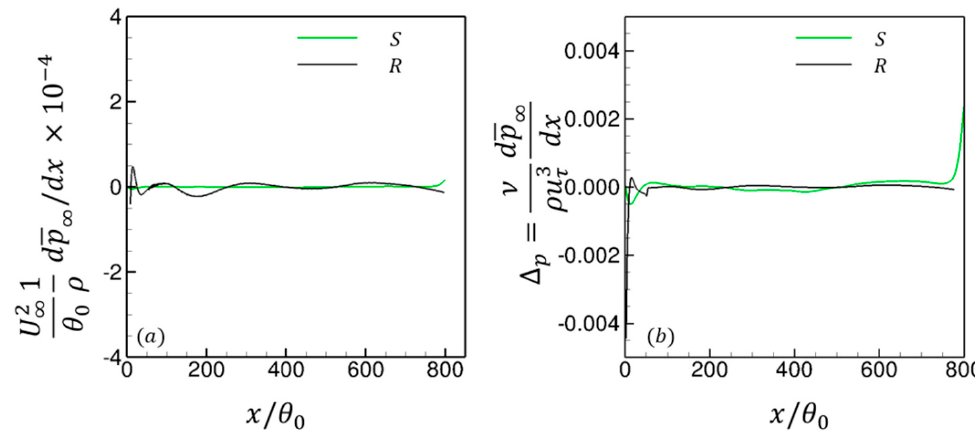
Table 1. Details on the construction of the domain and grid resolution. The subscripts 𝑤 and 𝛿 with Δ𝑦 (cid:2878) imply the grid spacing at the wall and at local TBL height, respectively.